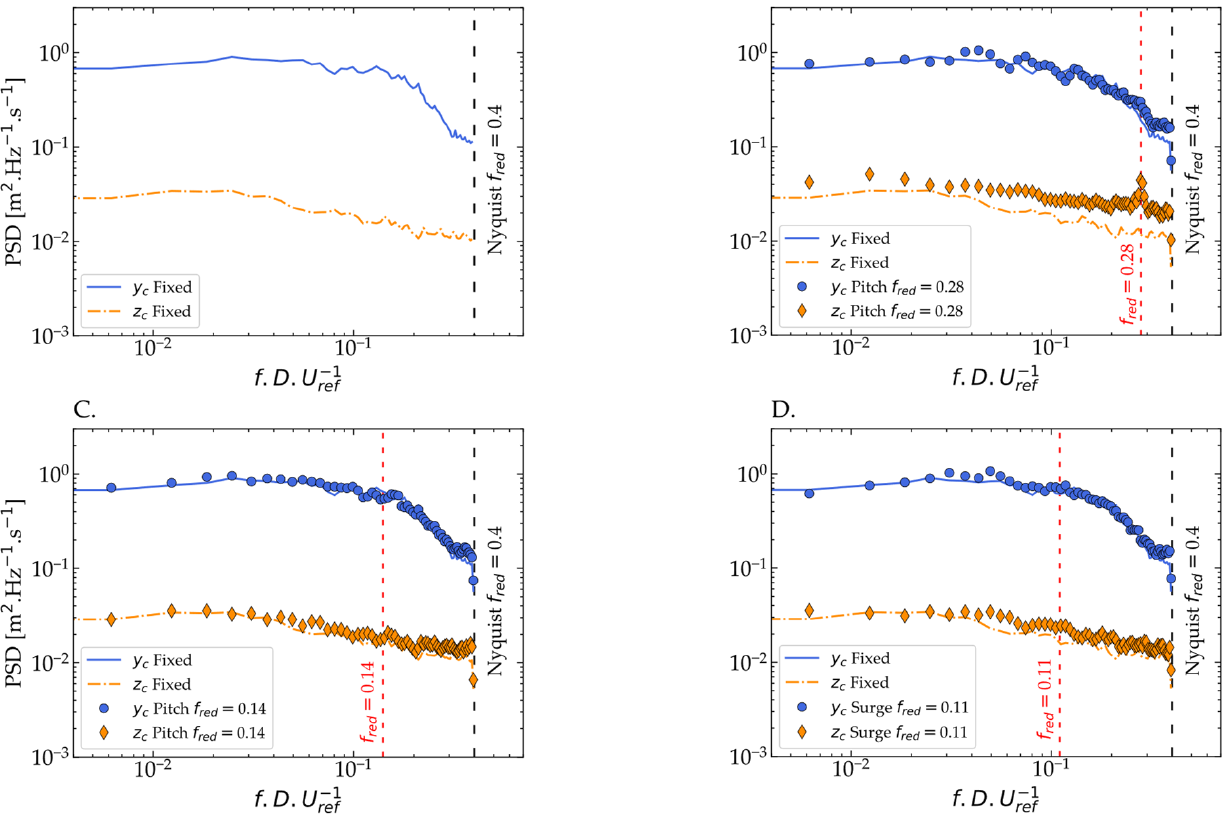
Figure 9. Spectral density spectrum of wake centres for different test cases. ( A ) Fixed model; ( B ) Pitch f red = 0.28; ( C ) Pitch f red = 0.14; ( D ) Surge f red = 0.11.